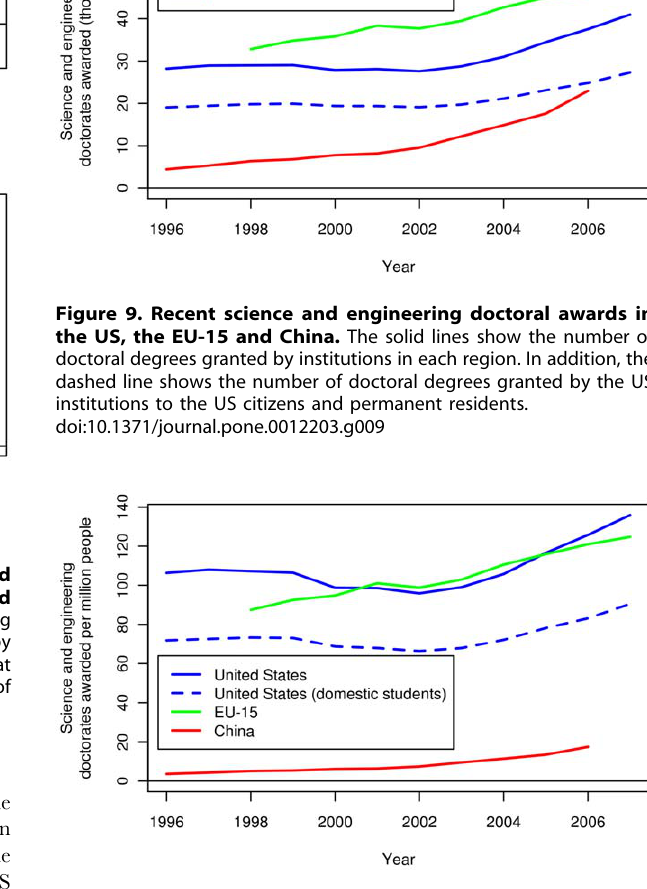
Figure 10. Per capita science and engineering doctoral awards in the US, the EU-15 and China. The solid lines show the number of doctoral degrees granted per capita by institutions in the US, the EU-15 and China. In addition, the dashed line shows the number of doctoral degrees granted per capita by the US institutions to the US citizens and permanent residents. Per capita figures were divided by the population of the region.